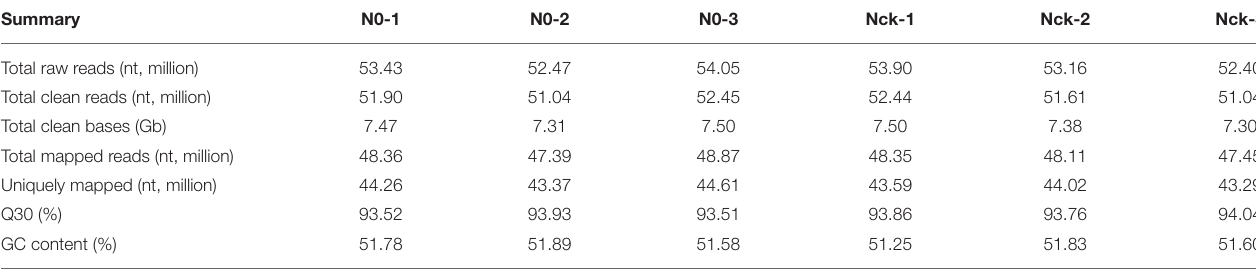
TABLE 1 | Transcriptome sequencing data quality and genome mapping results. Summary